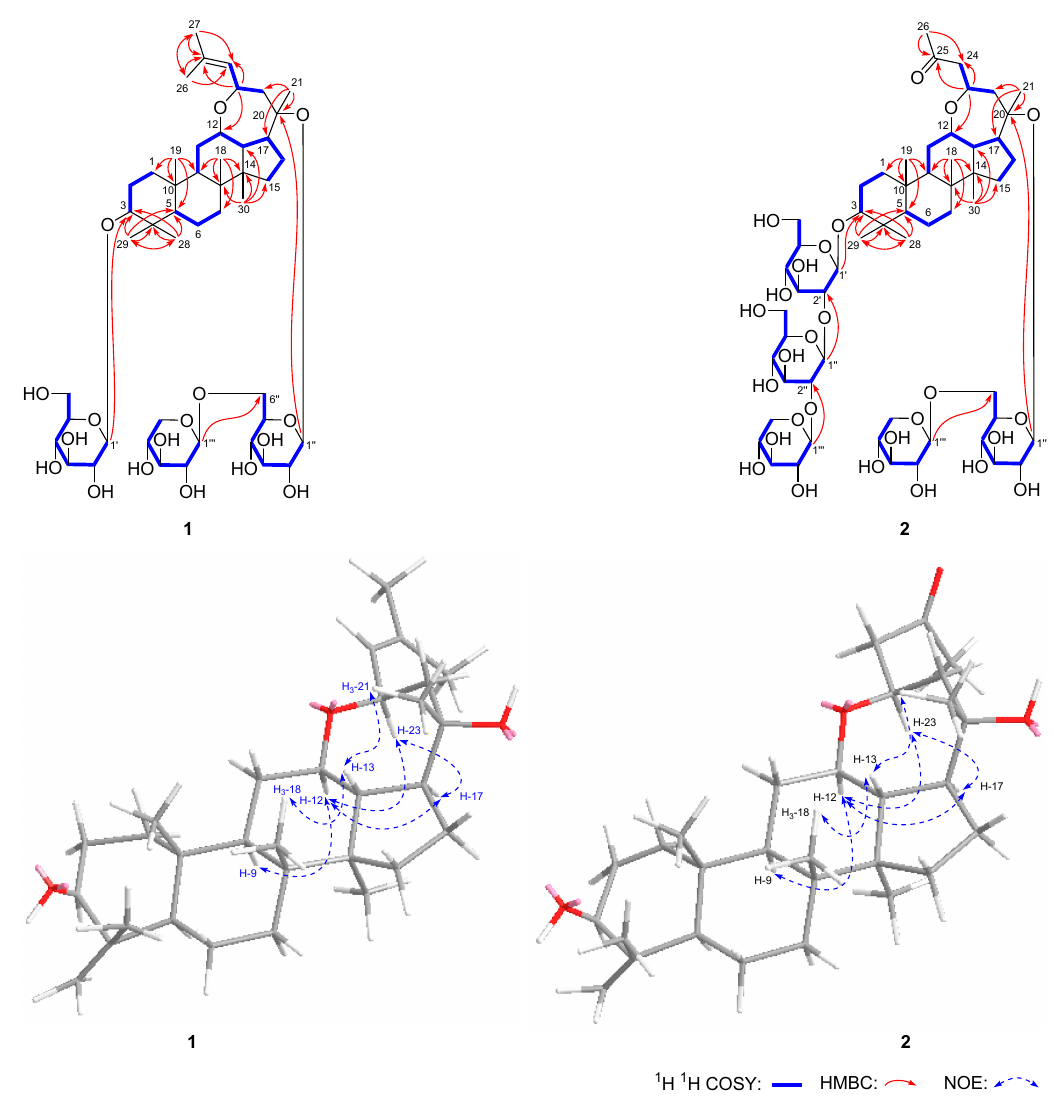
Figure 2. Main 1 H 1 H COSY, HMBC, and NOE correlations of ( 1 ) and ( 2 ) .